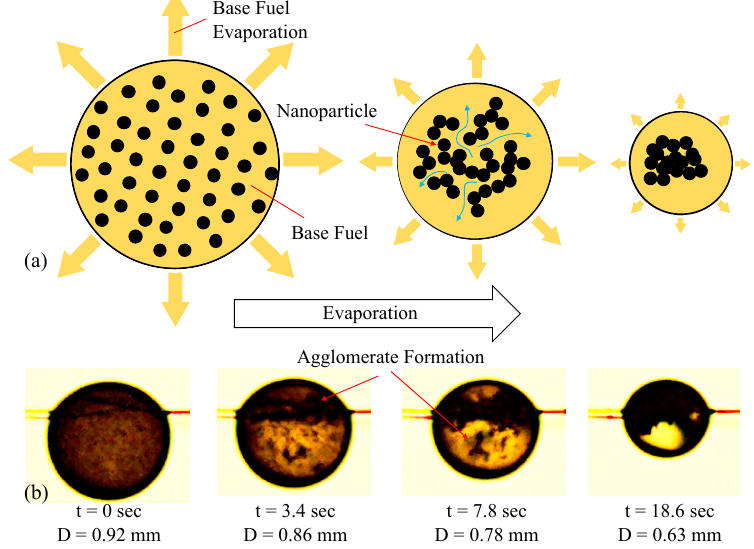
Figure 5. ( a ) Proposed mechanism of base fuel diffusion suppression by coagulation of nanoparticles; ( b ) time lapse of agglomerate formation in a droplet of 0.25% MWNT in jet fuel.